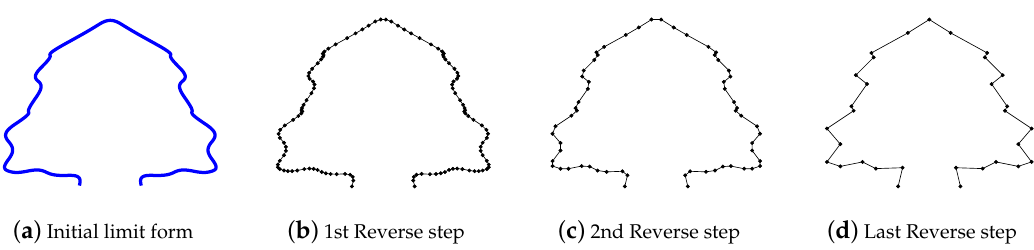
Figure 3. An open curve and their three levels of generalized B-spline reverse subdivision of order 3.